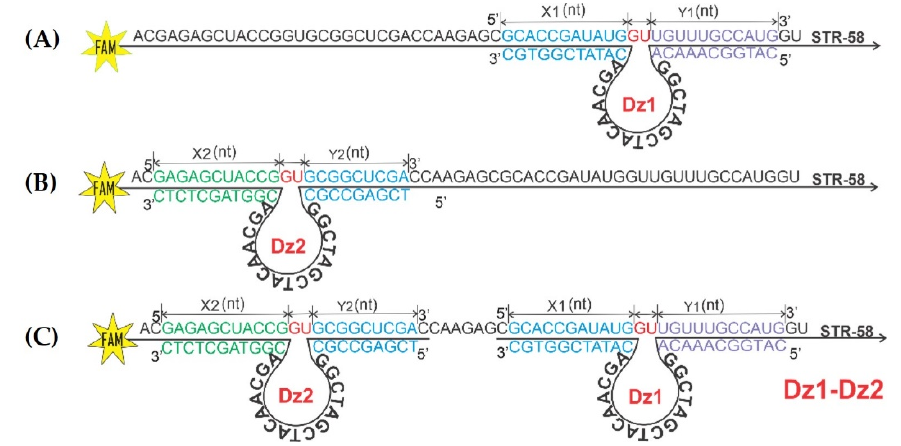
Figure 3. Design of Dz1 and Dz2. GU (red) site represent cleavage sites. X and Y are binding arms. X1 (blue) and X2 (green) are the binding arms at the 3′ end of Dz1 and Dz2. Y1 (purple) and Y2 (blue) are the binding arms at the 5′ end of Dz1 and Dz2. ( A ) Monovalent Dz1 cleaving at first cleavage site. ( B ) Monovalent Dz2 cleaving at second cleavage site. ( C ) Monovalent Dz1-Dz2 association cleaving at Dz1 and Dz2 cleavage sites.